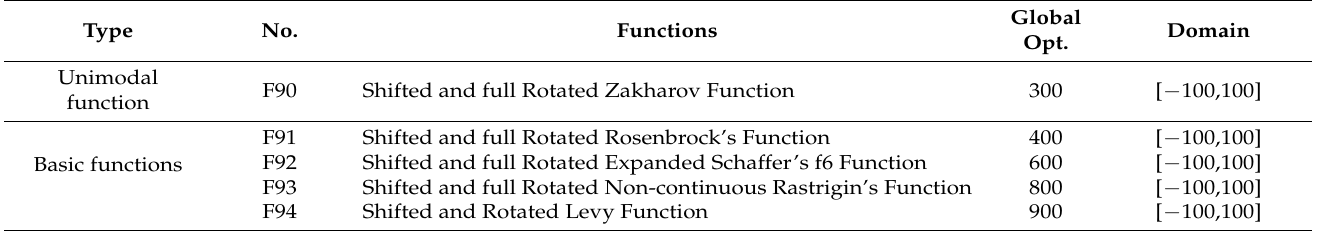
Table A7. Description of CEC2022